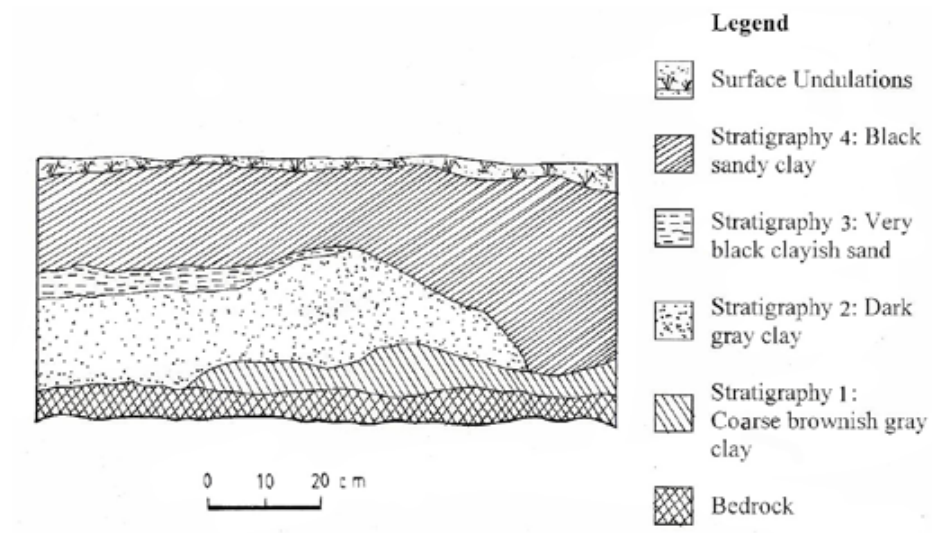
Fig 10: The profile of the southern wall of Nundu (ST1) Unit 1.